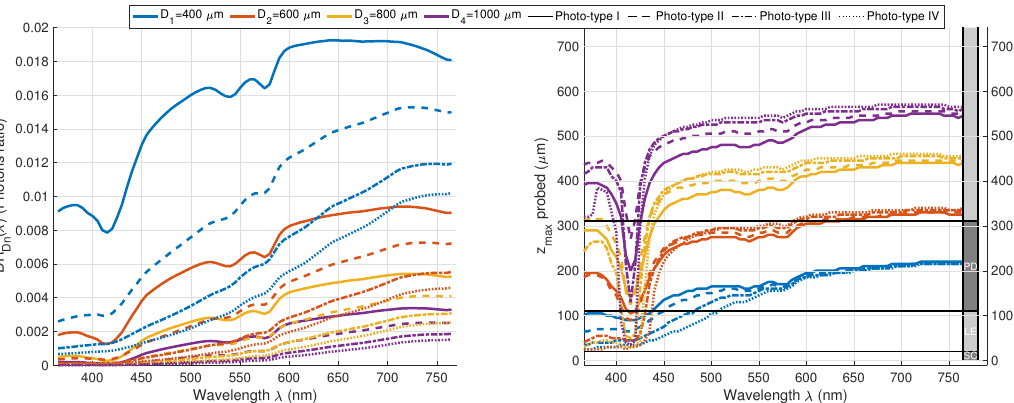
Figure 9. DR spectra ( left ) and maximum probed depth ( right ) for the four phototypes: I (line), II (dashed), III (dashed-dot) and IV (dotted). The SD distance D n is indicated by the color code. The right column represents the position of the border between the layers for the common geometrical